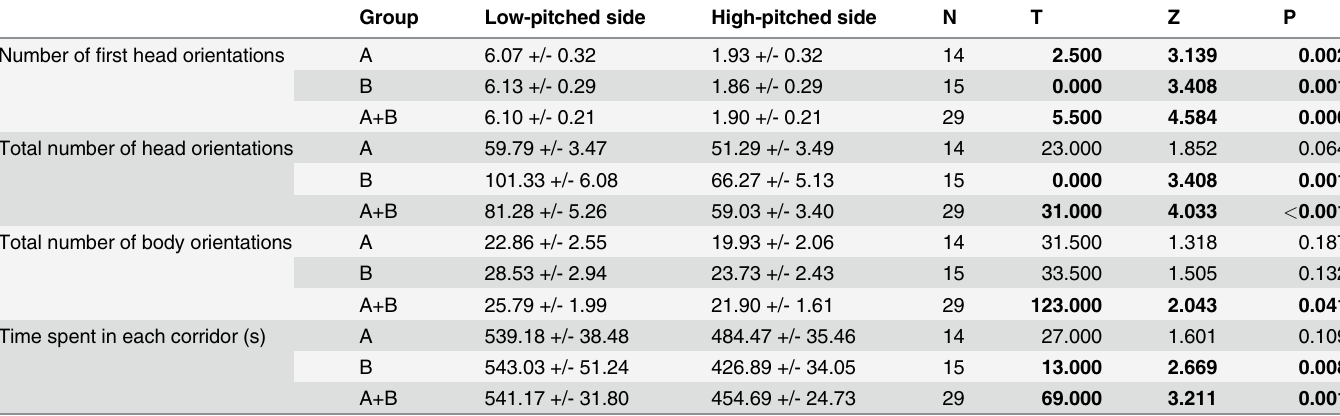
Table 6. Mares ’ responses to playbacks (Experiment 1).